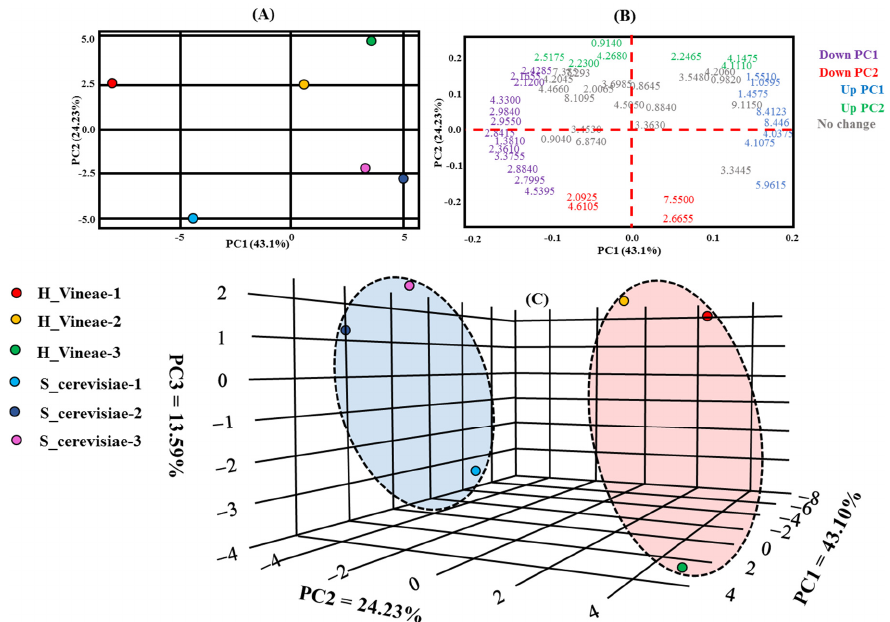
Figure 1. Principal component analysis (PCA) score plots comprising the 67.33% variance ( A ) and 80.92% variance ( C ) and chemical shift loading plots ( B ) obtained by a variable NMR bucketing procedure) of the data-reduced NMR fingerprints of Albillo white wines fermented at two different